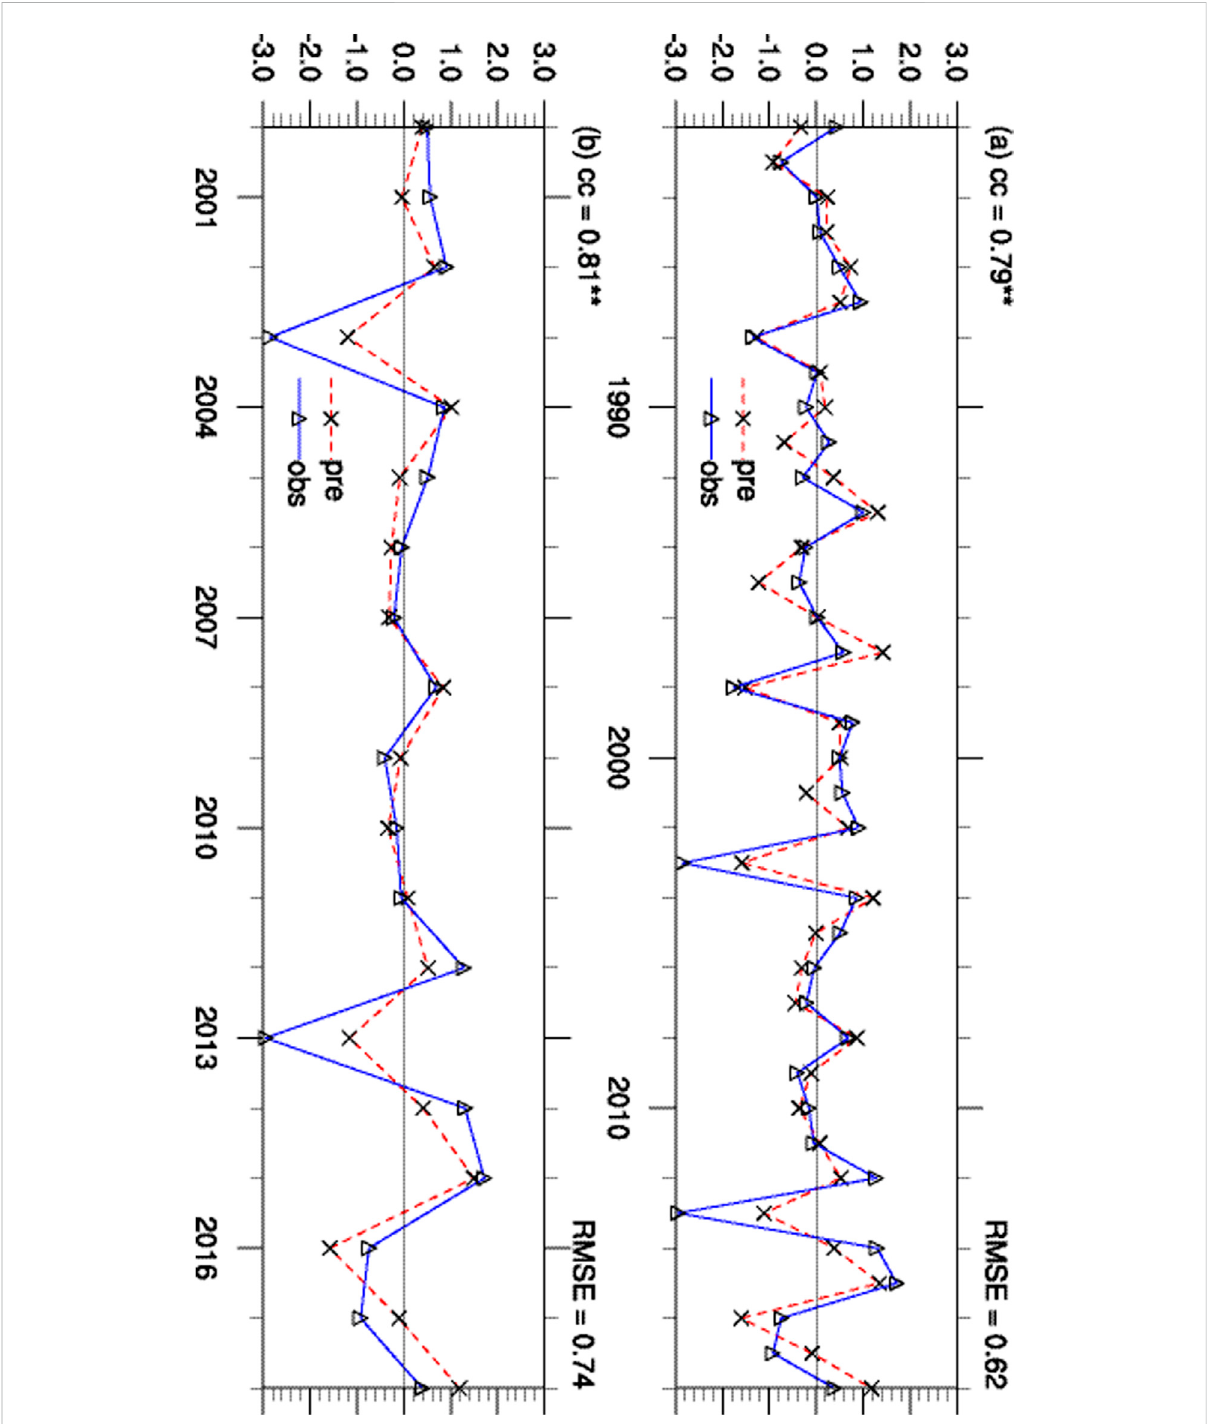
FIGURE 9 The physical – empirical model-predicted PC1 (PC1_PE, red dashed line) and PC1_obs (blue solid line) in (A) the one-year-leave cross- validation for 1982 – 2018 and (B) the independent hindcast for 2000 – 2018. The value in the top-left (top-right) corner of (A − B) is the correlation coef fi cient (RMSE) between PC1_PE and PC1_obs. ** denotes the correlation coef fi cients signi fi cant at the 99% con fi dence level based on Student ’ s t